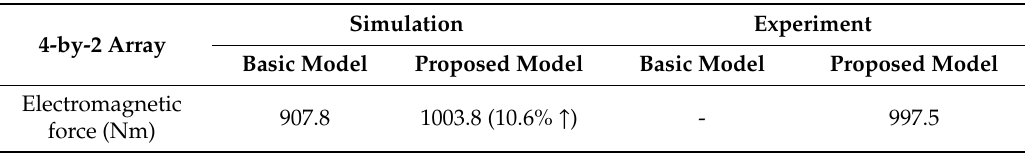
Figure 21. Evaluation system for the prototype H-EMM model. Table 5. Performance comparison between the conventional model, proposed model, and the prototype with the proposed design.